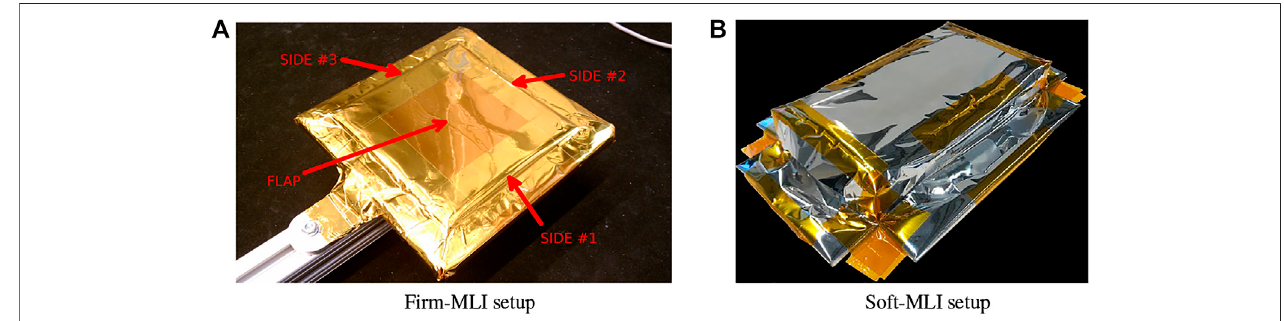
FIGURE 2 | Test platforms: (A) Firm-MLI setup, with MLI fl ap taped onto rigid surface of underlying satellite; (B) Soft-MLI setup, with MLI in shape of a rectangular